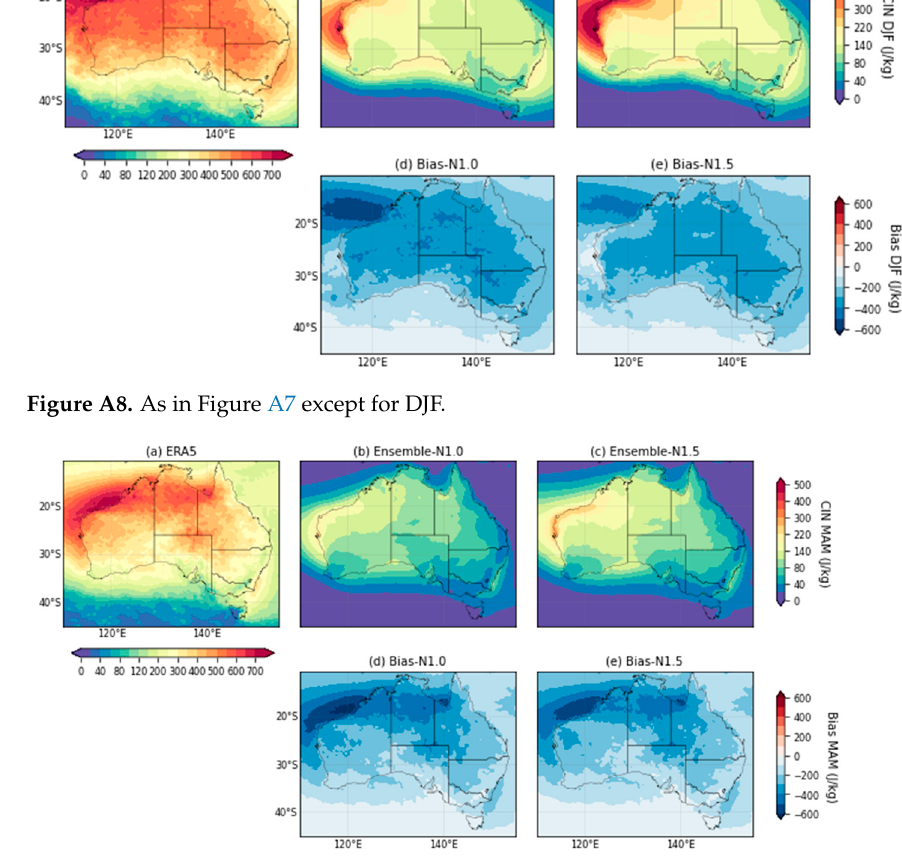
Figure A9. As in Figure A7 except for MAM.